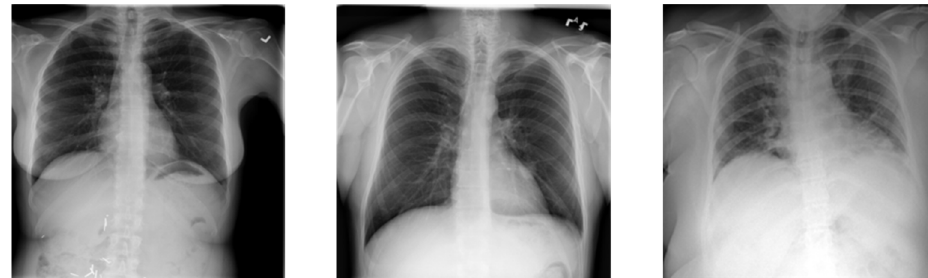
Figure 4. The distribution of X-ray images per class.